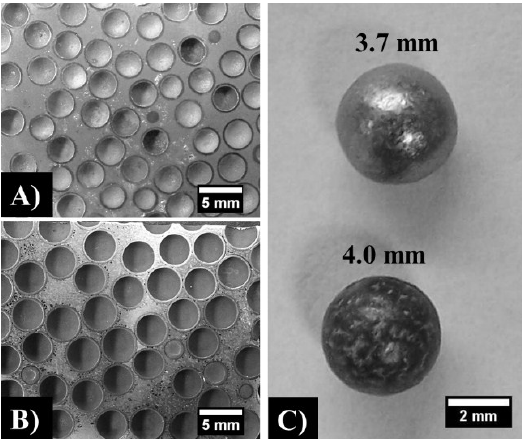
Figure 1. Digital images of the cross section of Al-S CMF samples processed using ( A ) 3.7 mm spheres and ( B ) 4.0 mm spheres, and ( C ) 3.7 and 4.0 mm diameter hollow